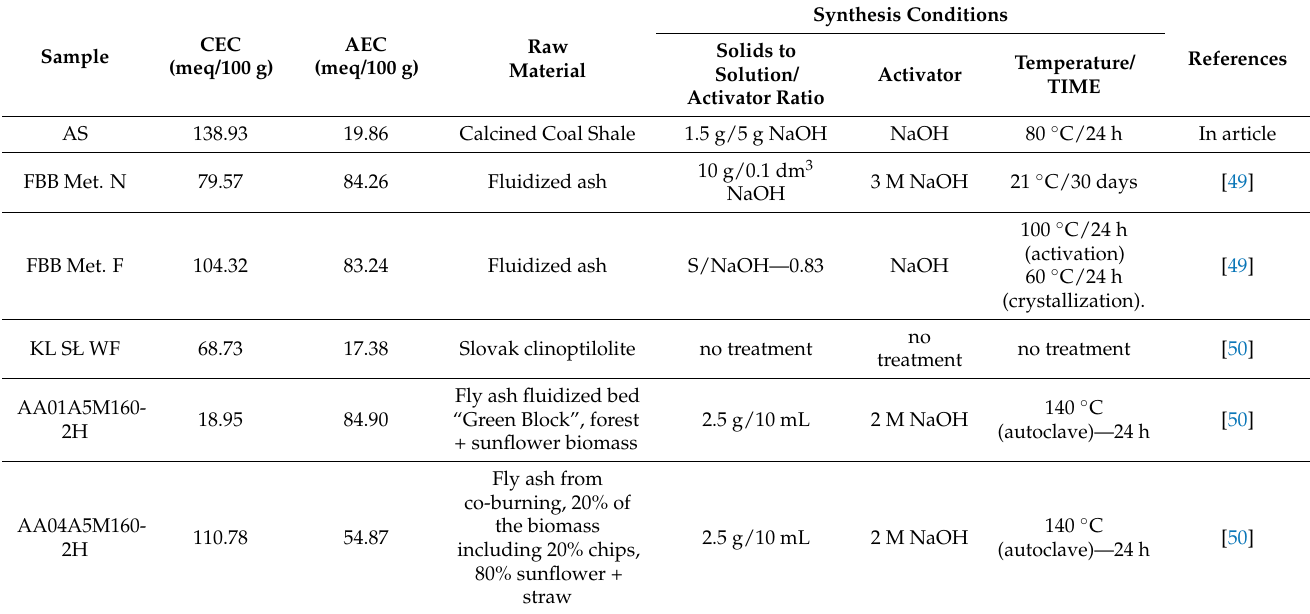
Table 5. CEC and AEC for sample AS and other natural zeolite materials, which were obtained by different synthesis